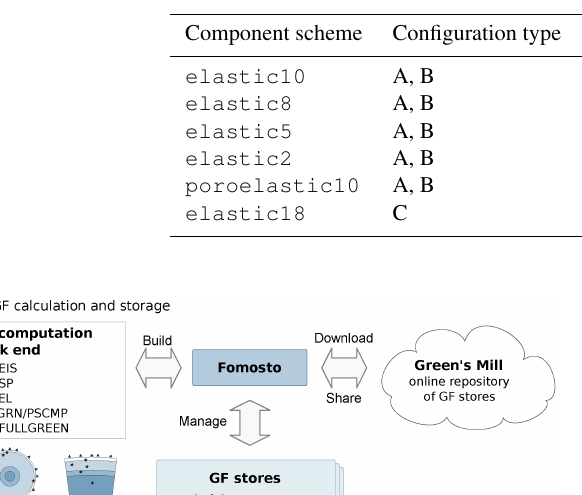
Table 1. Green’s tensor component schemes and configuration types for GF stores. Configuration types A and B stand for rotation-symmetric media with (A) common-depth receivers or (B) variable-depth receivers. Configuration type (C) is used for three-dimensionally heteroge- neous media with sources in a defined source volume and receivers at fixed positions.